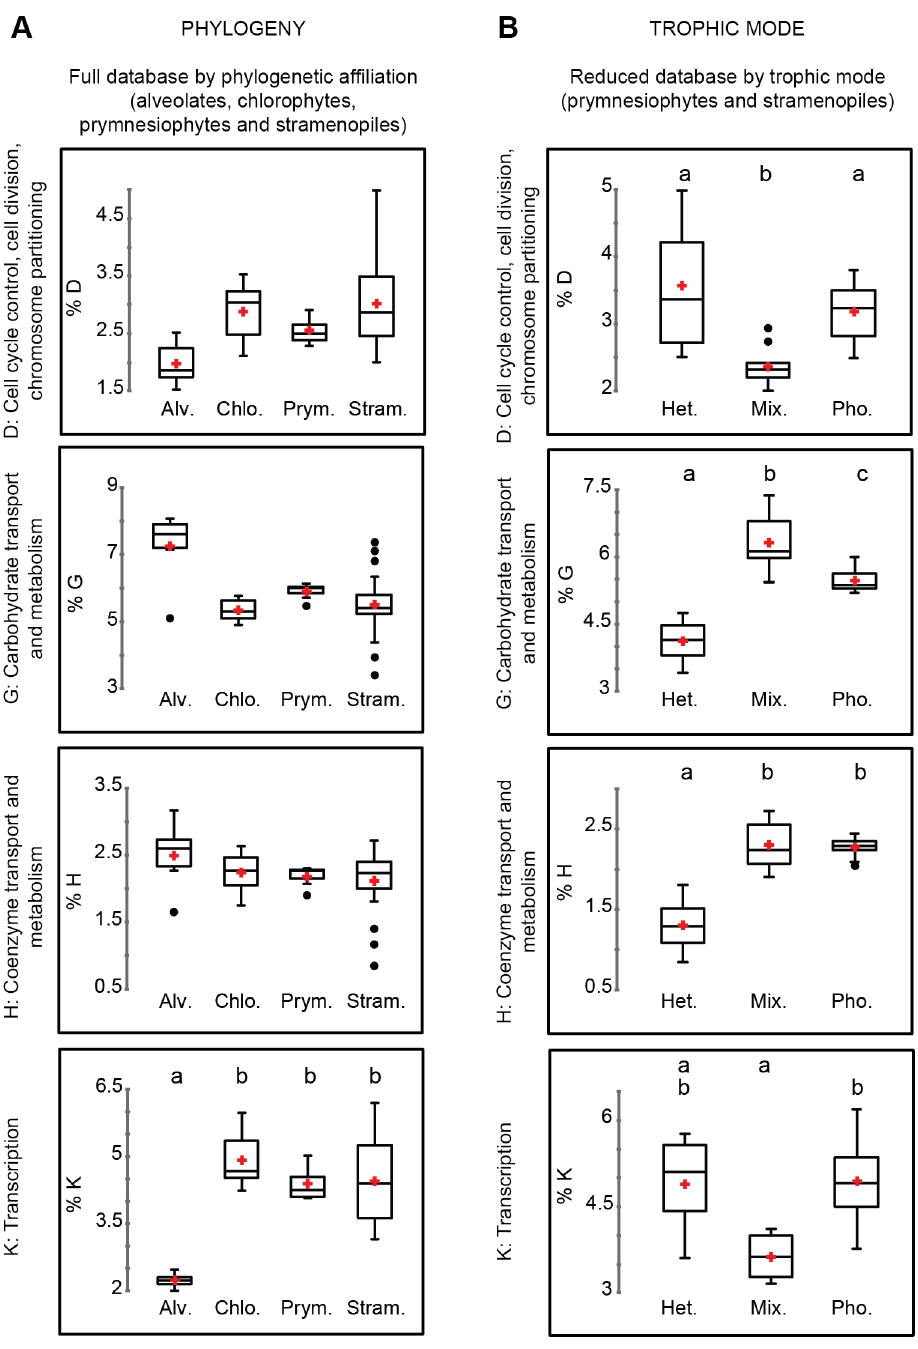
Figure 7. Box plots of the proportion of genes assigned to KOG functions that had a statistically significant difference among phylogenetic and trophic modes (see Table S4). A) The full dataset of 41 species (excluding the mycetozoan Dictyostelium purpureum , the choanoflagellate Monosiga brevicollis and the rhodophyte Cyanidioschyon merolae ) showing the proportion of genes annotated with a particular KOG function and grouped by higher-level taxonomic affiliation; B) A reduced dataset of the proportion of genes assigned to particular KOG function in the prymnesiophytes and stramenopiles, grouped by trophic modes. The alveolates and chlorophytes were excluded to reduce phylogenetically- based bias in the dataset. Small case letters over each bar summarize the different statistical groups found by multiple pairwise comparisons. Red crosses indicate the mean for each group and black dots represent the outliers.